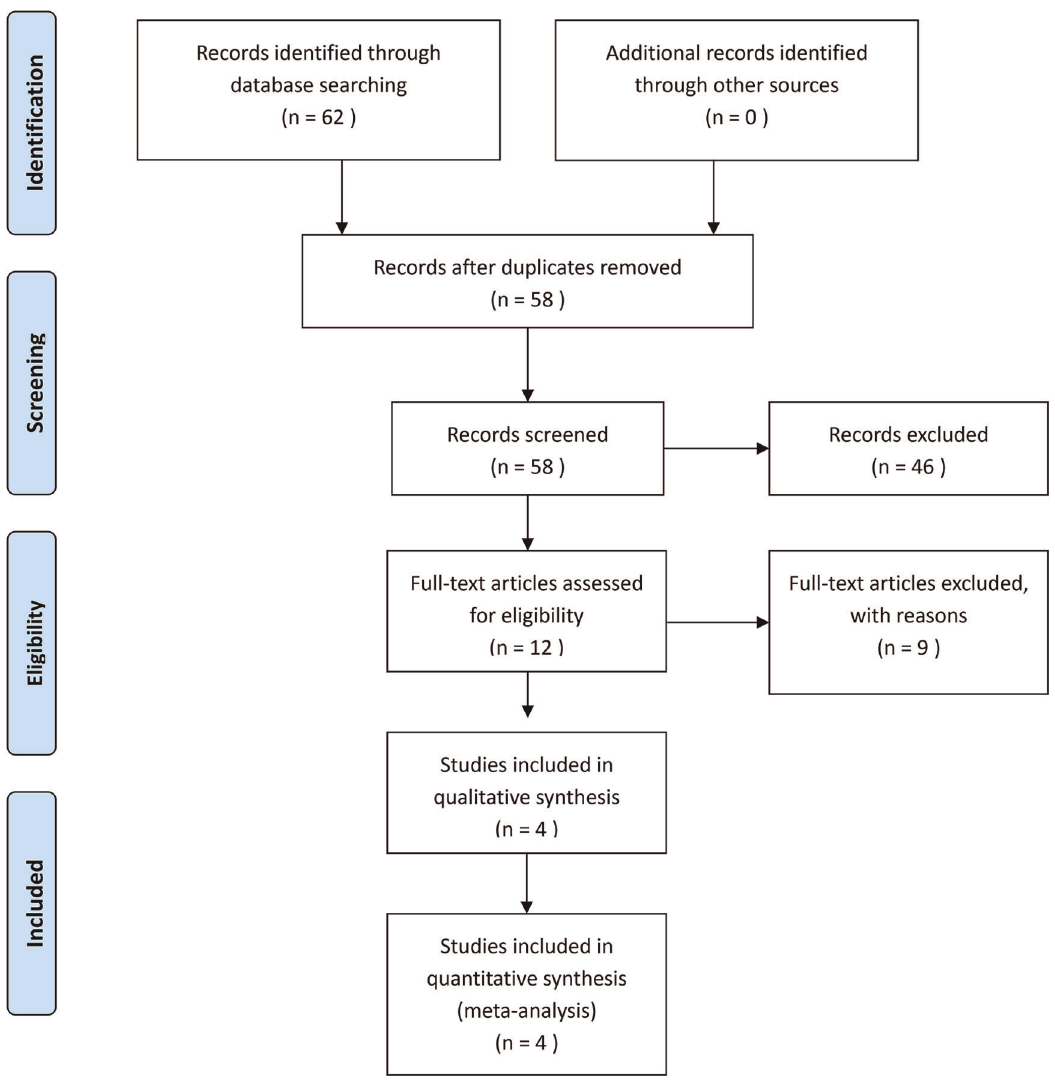
TABLE 1 The fl owchart of the analyzed